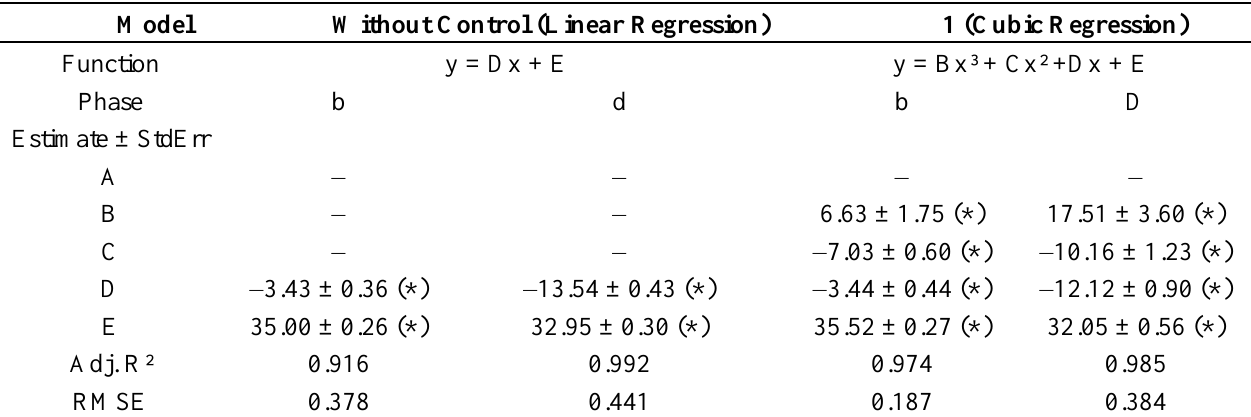
Table 2. Regression functions and model parameter estimates for all the data given in Figure